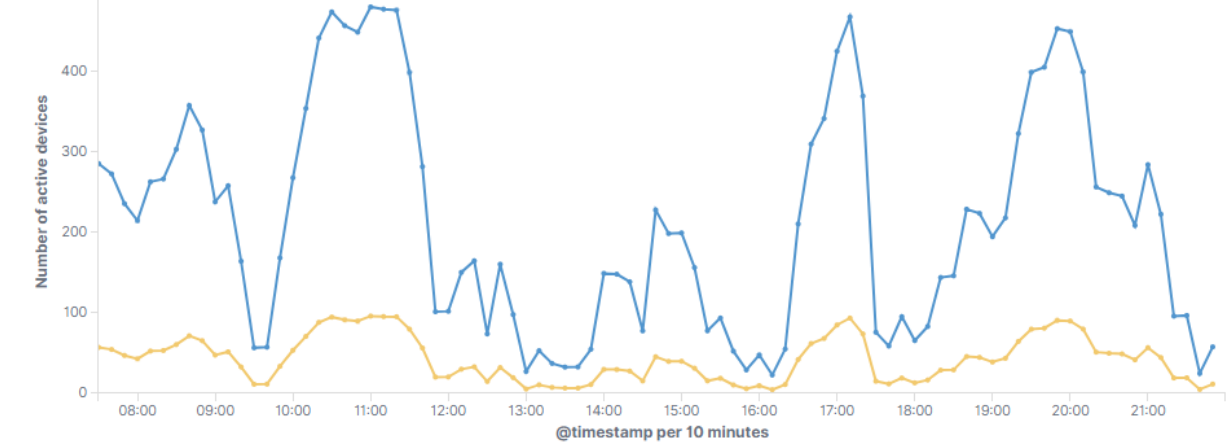
Figure 9. Active devices (absolute number in blue, percentage in orange).